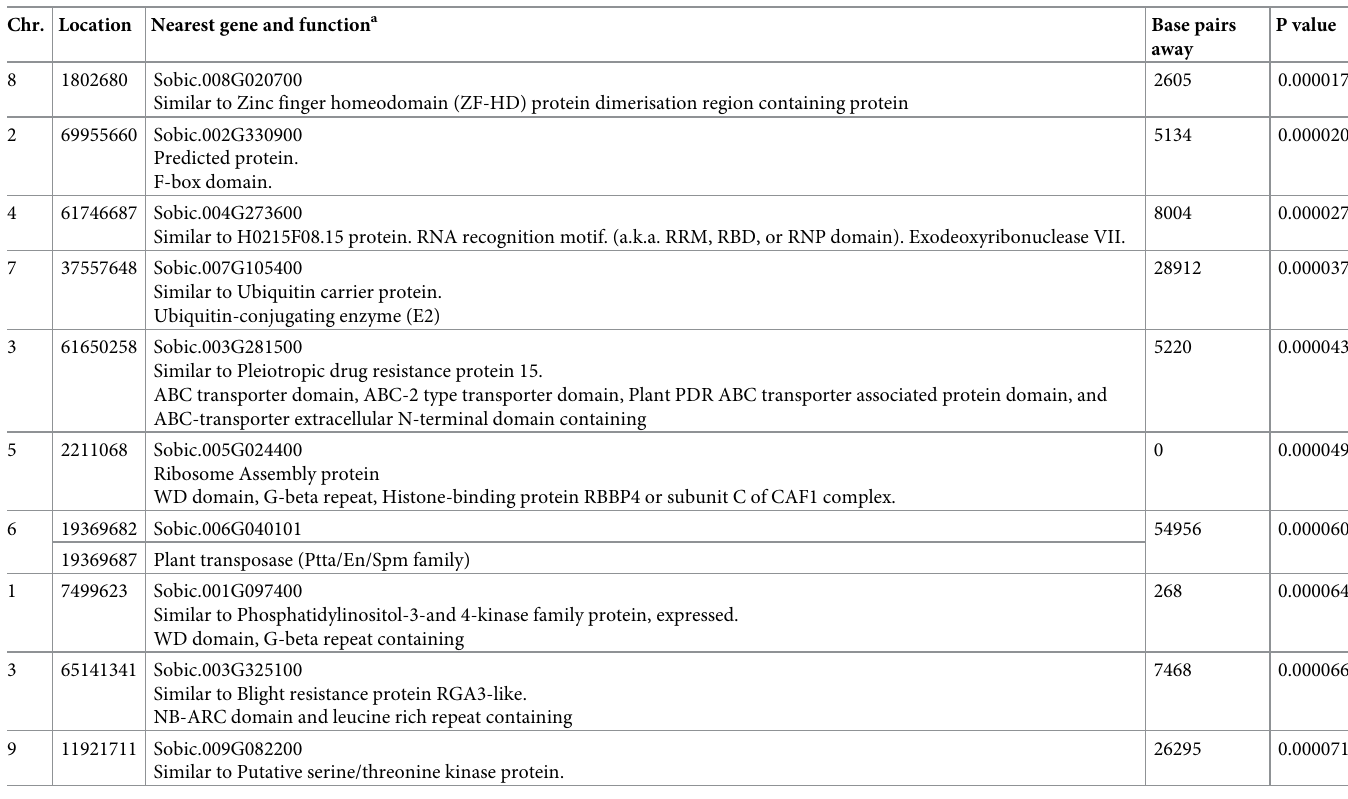
Table 1. Top SNPs associated with anthracnose. Chr. Location Nearest gene and function